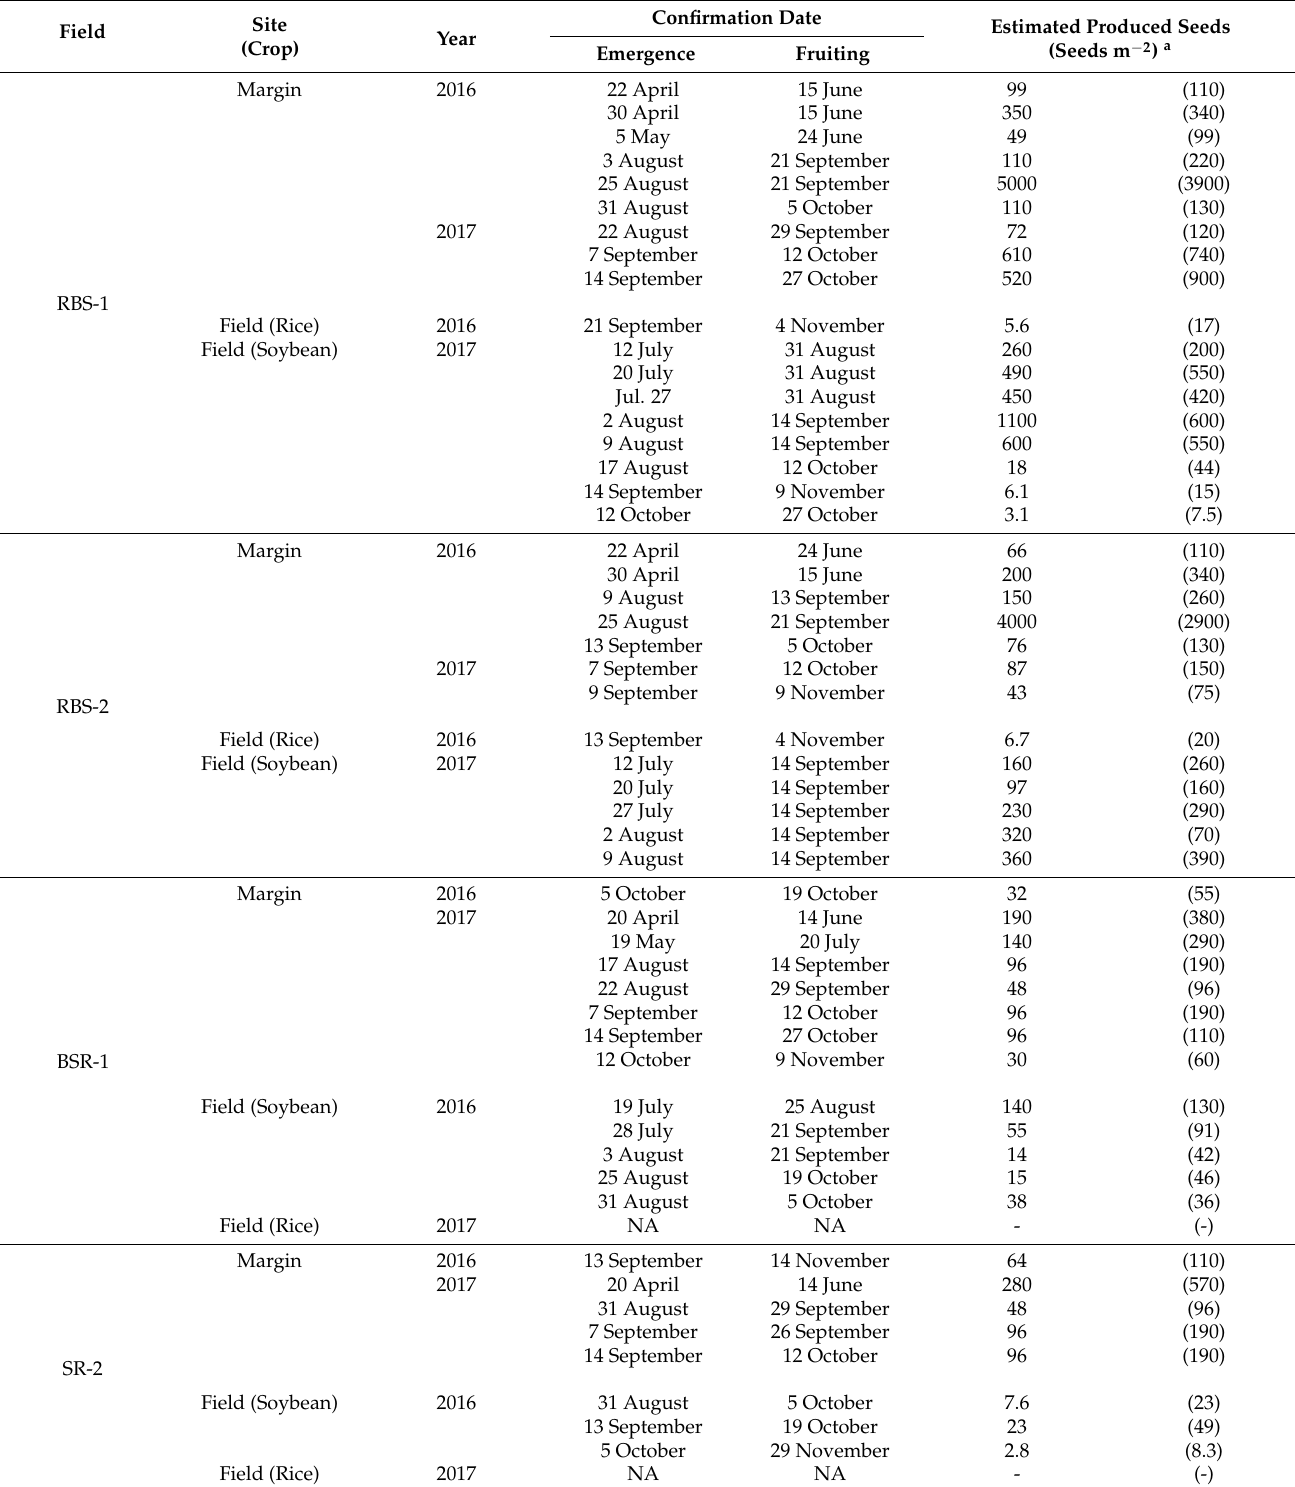
Table 2. Confirmation date of emergence and fruiting, and the estimated number of seeds of entireleaf morning glory produced in the fields and their